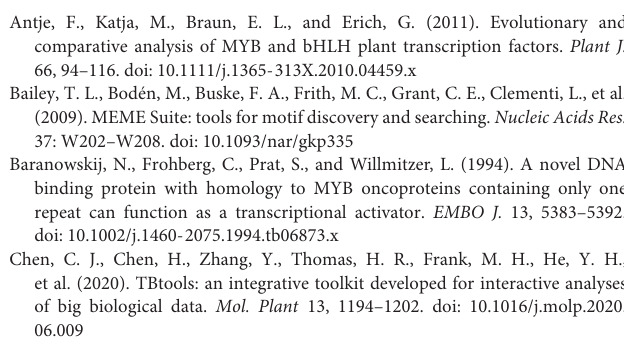
Supplementary Figure 1 | Sequence logos of the MYB-related domains of subgroups. Supplementary Figure 2 | The classification and frequency of each subgroup on each chromosome. Supplementary Figure 3 | Tandemly and segmentally duplicated genes visualized in the O. fragrans genome. Supplementary Figure 4 | The expression patterns of three candidate OfMYB1Rs , on the basis of three reference genes ( ACTIN , RAN , and RBP2 ). Supplementary Figure 5 | Subcellular localization of candidate OfMYB-related proteins. Supplementary Figure 6 | Floral composition analysis after infiltration with 35S: OfMYBMYB1R70/114/201 :GFP and control vectors (VIP > 1 and P < 0.05). Supplementary Figure 7 | OPLS-DA plots generated from comparisons among three types of plants with transient expression and negative control vector plants with transient expression (NC). Supplementary Figure 8 | The process of transient expression in N. benthamiana